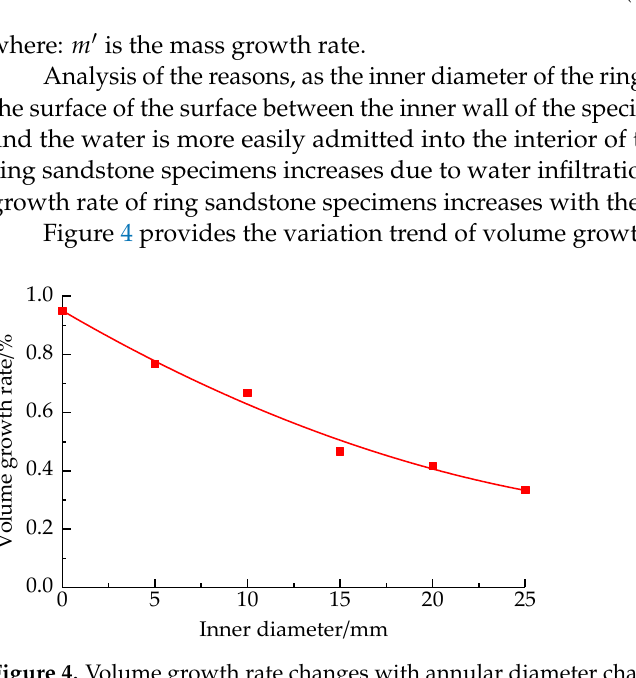
mula is shown in (1).